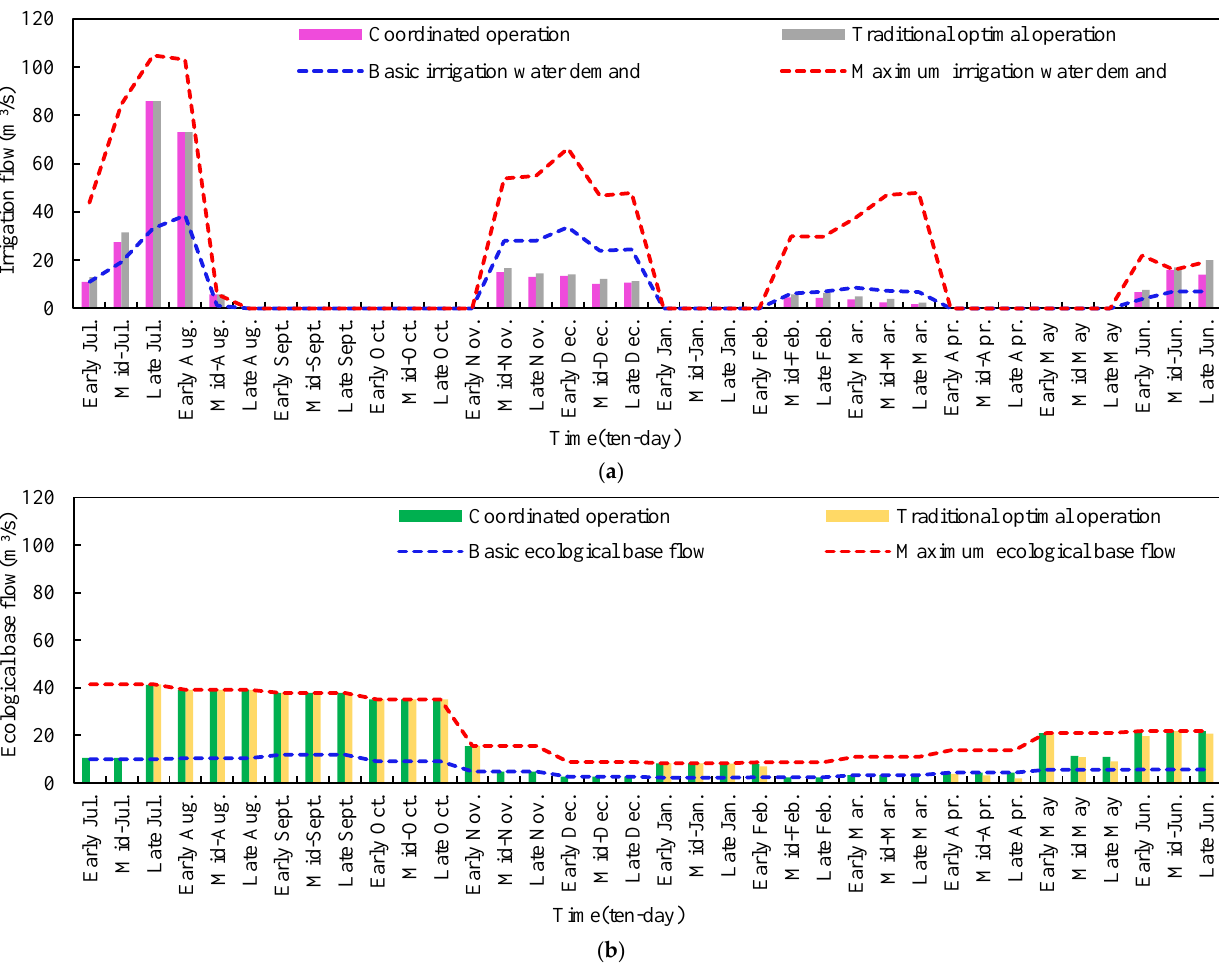
Figure 8. Irrigation and ecological water supply processes of two operation methods in a dry year: ( a ) irrigation; ( b ) ecology.